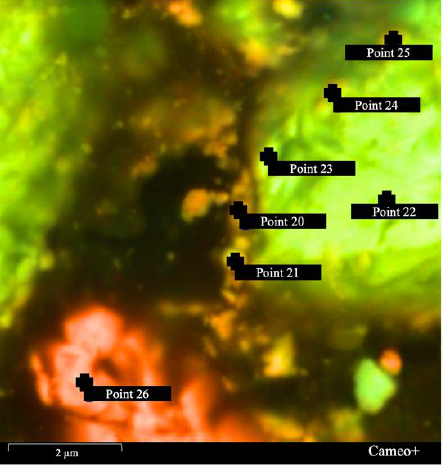
Figure 12. SEM image of the sector, shown in Figure 11A.